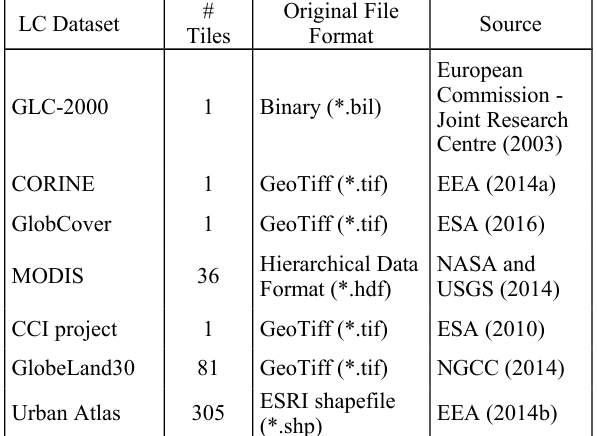
Table 2. Source of the LULC datasets of Europe